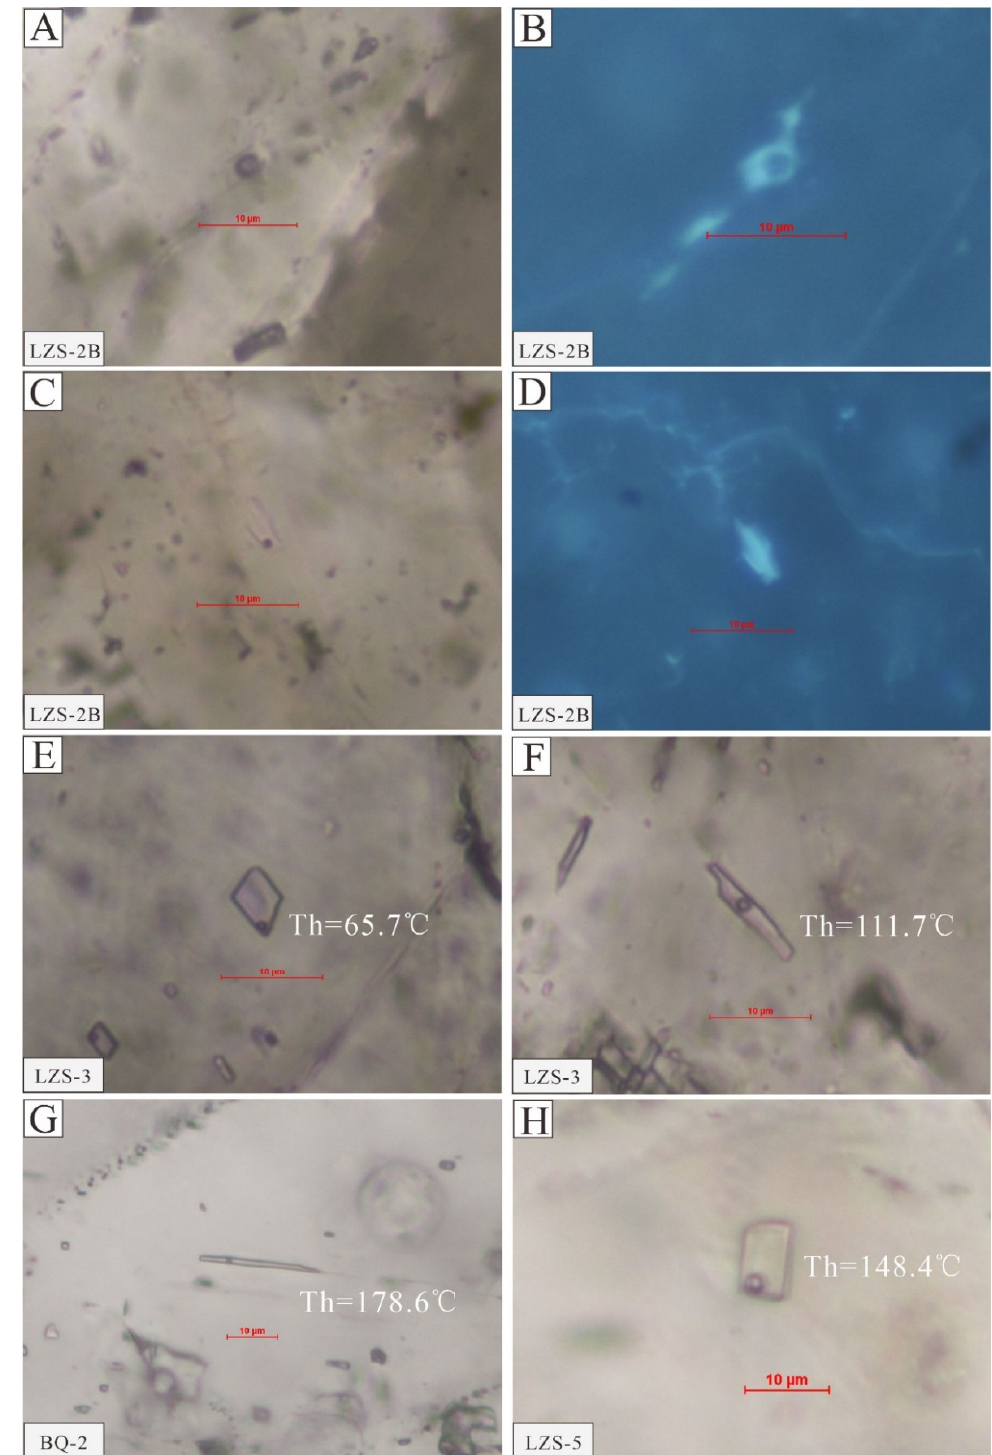
Figure 8. Typical characteristics of fluid inclusions in calcite in the Banqi-Yata-Laizishan area, Nanpanjiang-Youjiang Basin. ( A – D ) Irregular hydrocarbon inclusions, blue–white under fluorescence. ( E ) aqueous fluid inclusions, negative crystal, Th = 65.7 °C. ( F ) short columnar-shaped aqueous fluid inclusions, Th = 111.7 °C. ( G ) needle-like shape aqueous fluid inclusions, Th = 178.6 °C. ( H ) rectangle-shaped aqueous fluid inclusions, Th = 148.4 °C.